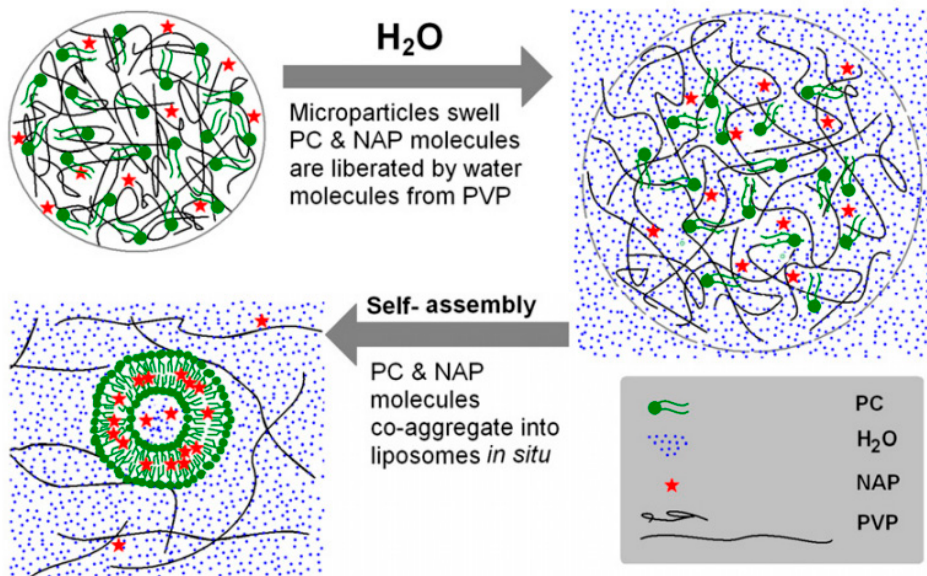
Figure 4. Schematic diagram illustrating the self-assembly of liposomes from microparticles based on PVP-PC, containing naproxen (NAP) as a loaded drug agent. Used with permission of IOP Publishing, Ltd., from [96]; permission conveyed through the Copyright Clearance Center, Inc.